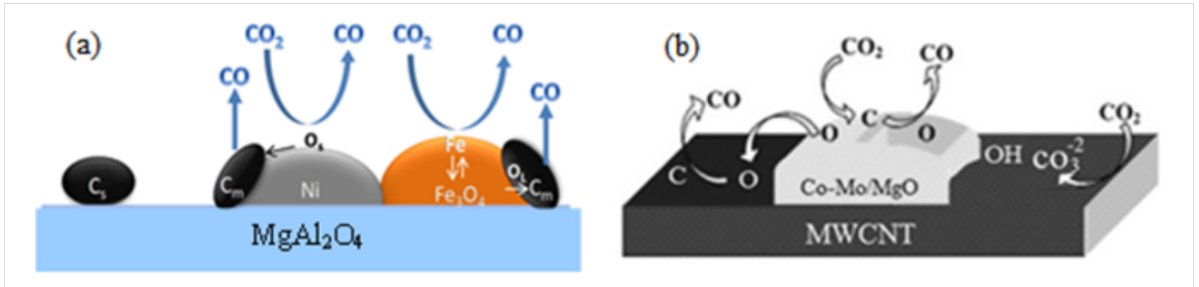
Figure 3: Schematic diagram of carbon species removal by CO 2 over (a) Fe–Ni catalyst [28] and (b) Co–Mo–MgO/MWCNT nanocomposite. [69]. (C s : deposited carbon far from metals, O s : surface oxygen, O L : lattice oxygen, C m : carbon deposited on metals). Reprinted with permissions from [28] and [69], copyright 2016 and 2014, respectively, Elsevier.